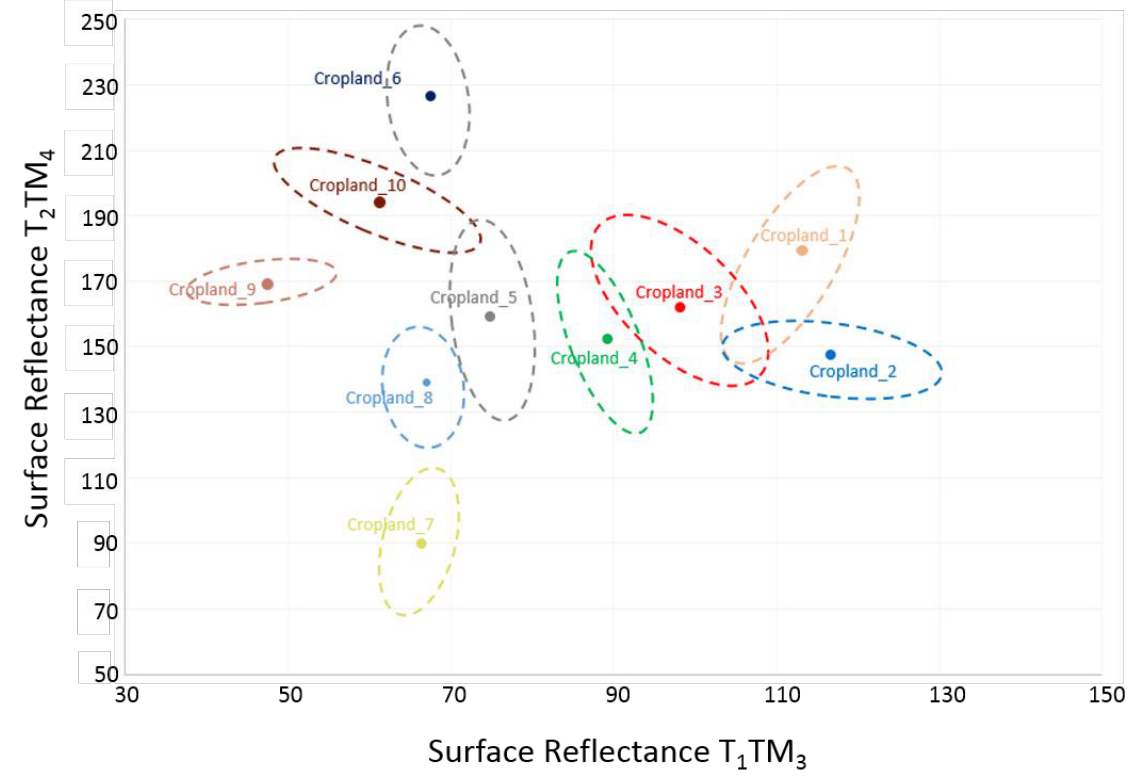
Figure 3. Distribution of cropland clusters in T 1 TM 3 (x-axis) and T 2 TM 4 (y-axis) feature space. Dashed lines delineate the distribution of individual signatures that compose the respective cluster. TM 3 is utilized to illustrate soil reflectance variability and TM 4 to illustrate the variability in vegetation response. Surface reflectance is scaled to unsigned